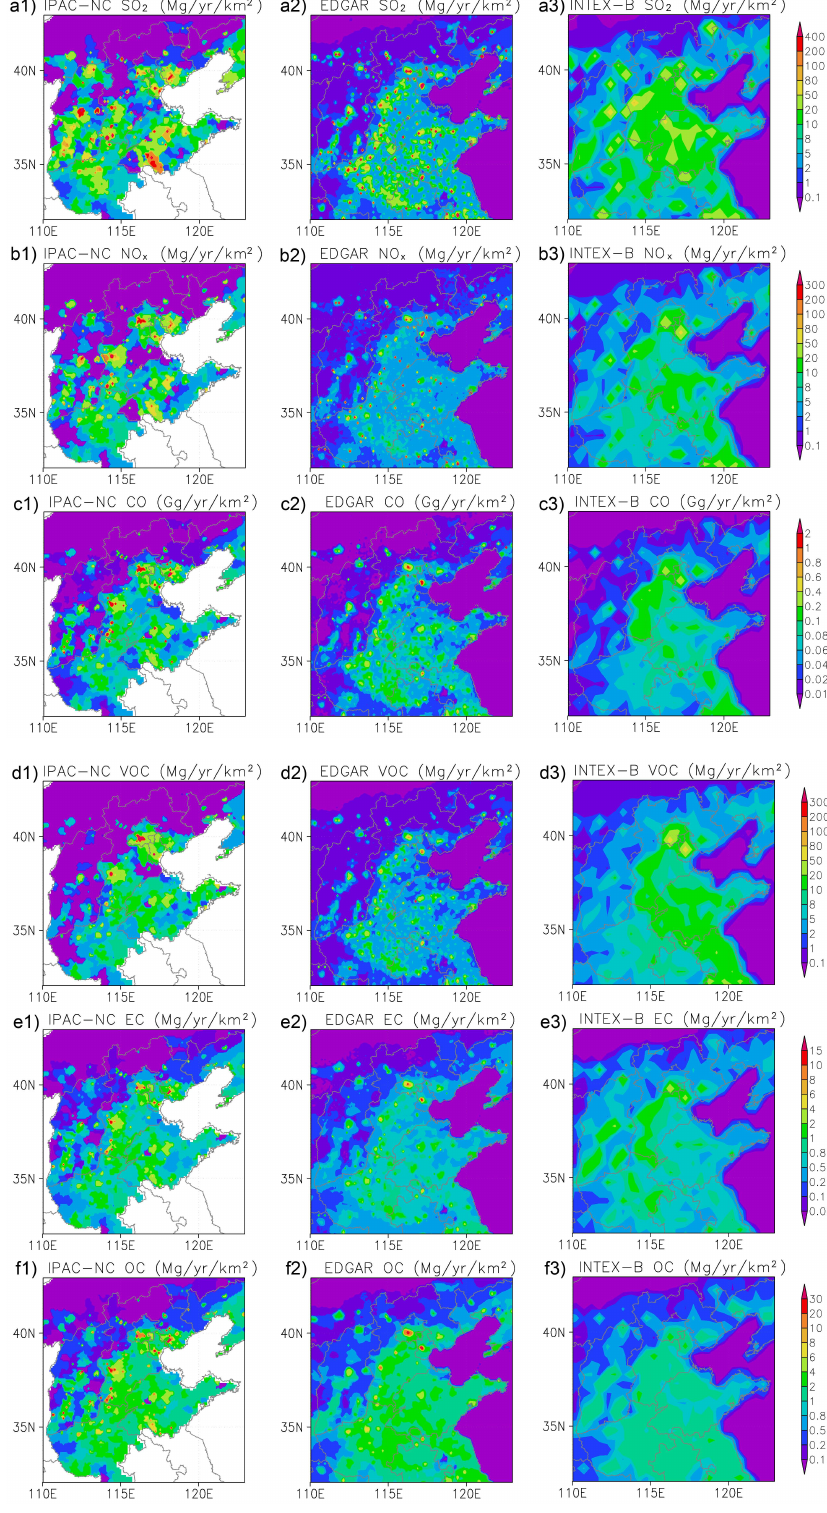
Fig. 7. Comparisons of the 2003 IPAC-NC inventory developed in this study with the 2005 EDGAR-CIRCE inventory and the 2006 INTEX- B inventory in respect of emission distributions in Huabei. Units are Mg/yr per square kilometre except for the CO emission rates, which have a unit of Ggyr − 1 per square